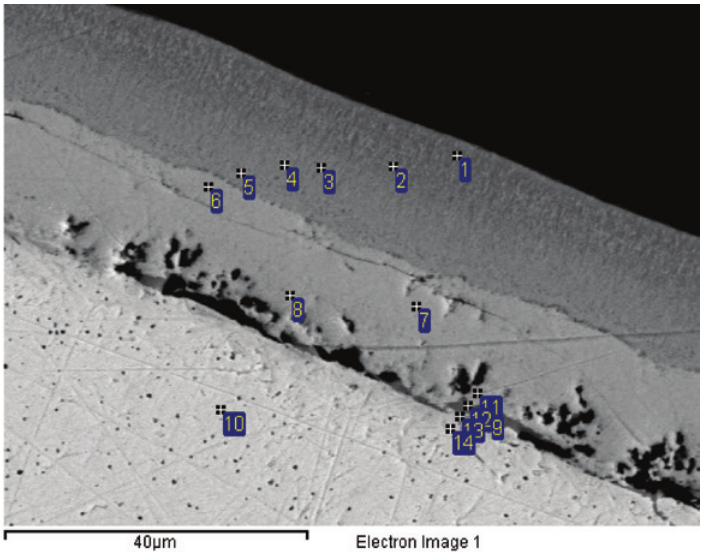
Fig. 2: Copper oxide scales on Cu 2 Se generated by a flowing dry O 2 roasting atmosphere at 450 °C within 4 h reaction time; the outer layer against atmosphere is CuO (points 1–5) and inner predominantly of Cu 2 O (points 6–8) with traces of selenium-copper-oxides (dark grey, points 9, 11–13) next to Cu 2 Se (points 10,